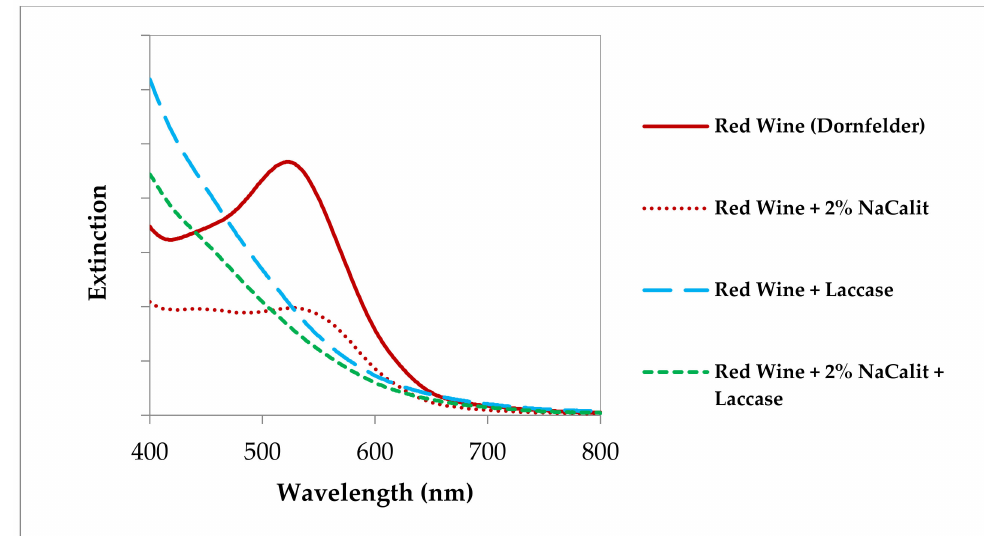
Figure 7. VIS spectra of a Dornfelder red wine after incubation with a model laccase from Polyporus pinisitus and in the presence of a Na-Ca-bentonite